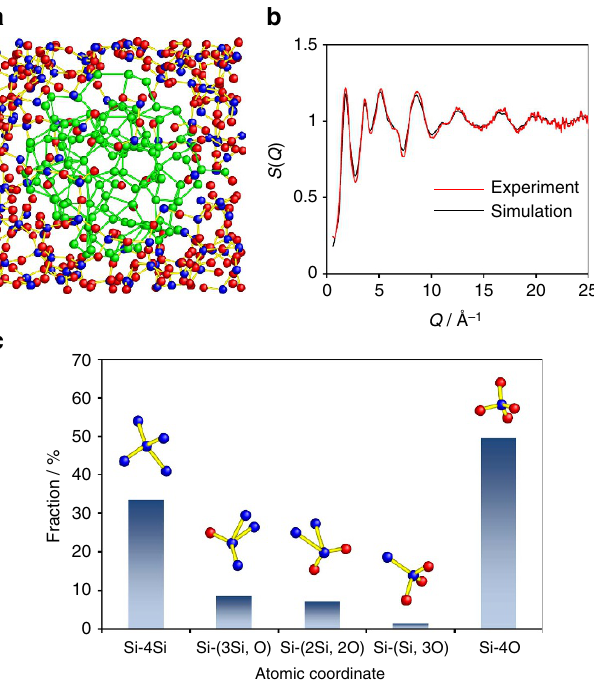
Figure 4 | Atomic model of disproportionated amorphous SiO. ( a ) Reconstructed heterostructure model of amorphous SiO. The inner part corresponds to an amorphous Si cluster and the outer part is amorphous SiO 2 matrix. The blue, red and green circles denote Si and O in amorphous SiO 2 and Si in the Si cluster, respectively. ( b ) Experimental and simulated X-ray total structure factor S ( Q ) curves. The red curve denotes the experimental S ( Q ) data obtained from the HEXRD measurements. The black curve shows the S ( Q ) data obtained from heterostructure model after RMC refinement. ( c ) Fractions of the five atomic coordinates found in amorphous SiO. Si–4Si and Si–4O are from the Si cluster and SiO 2 matrix while Si-(3Si, O) Si-(2Si, 2O) and Si-(Si, 3O) appear at the interfacial regions between the Si cluster and amorphous SiO 2